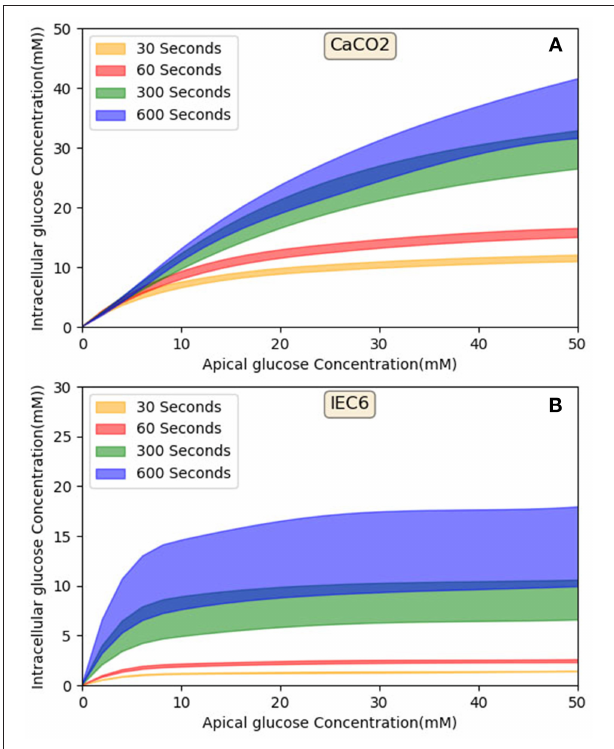
FIGURE 10 | Model output—Intracellular glucose concentration vs. Extracellular glucose concentration in (A) Caco2 cell line and (B) IEC6 cell